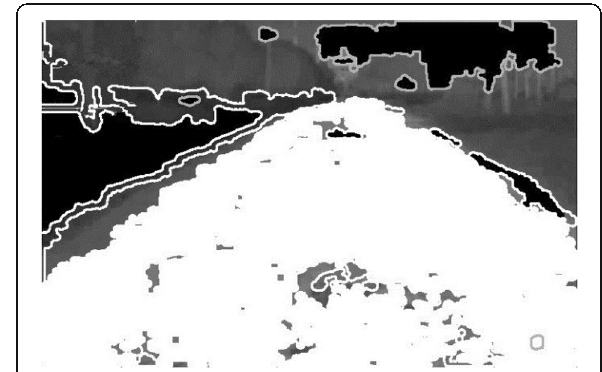
Fig. 6 Result of classification-normalized